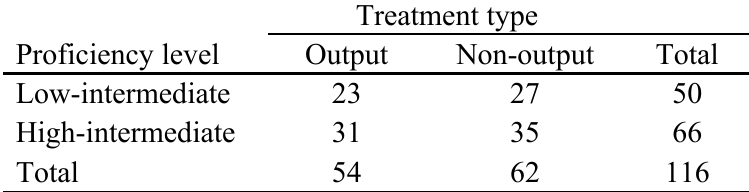
The Number of Participants in the Four Treatment